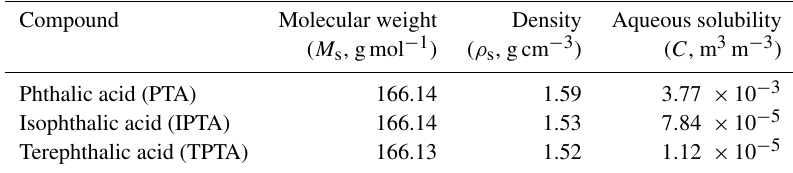
Table 1. Physical and chemical properties of AAA compounds used for calculation throughout this paper.